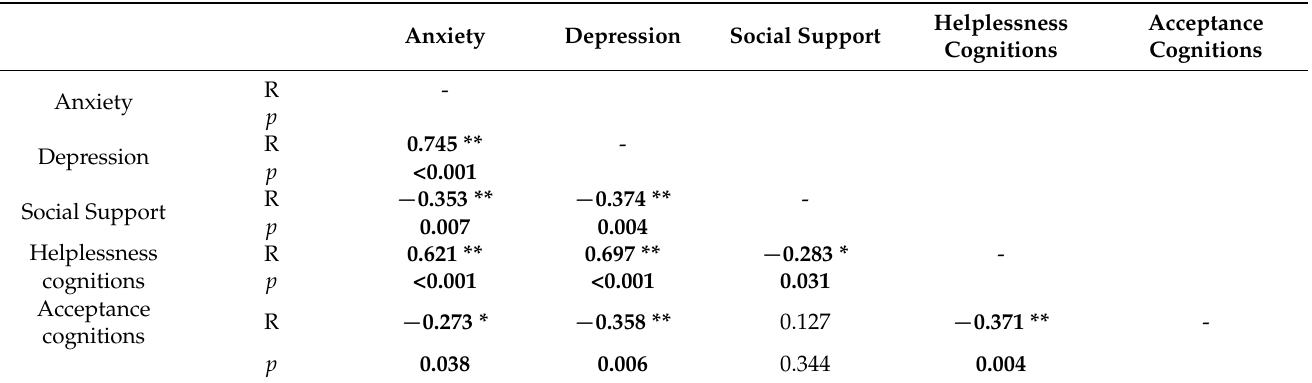
Table 4. Correlation between the SCREENIVF dimensions.